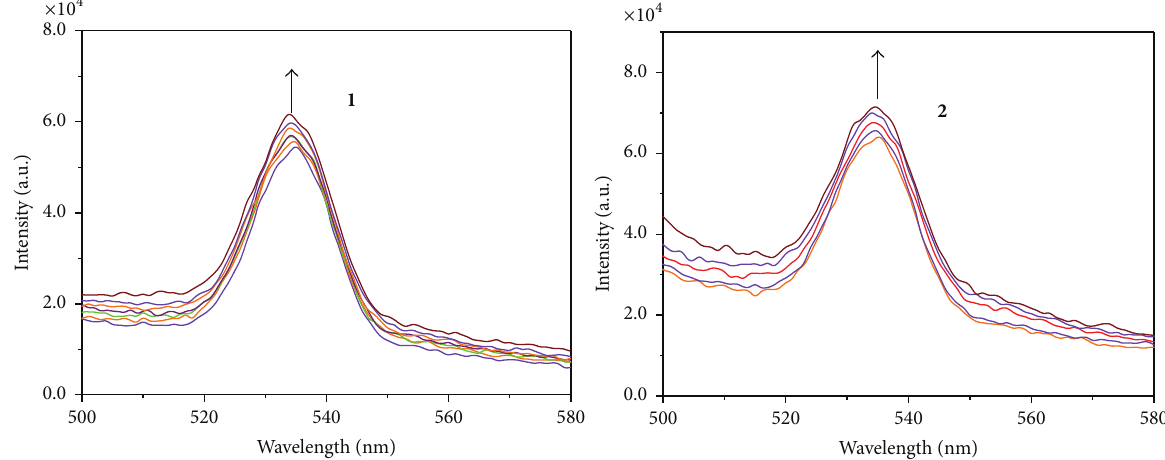
Figure 4: Emission spectra of complexes 1 and 2 in Tris/KCl buffer (100mM KCl, 10mM Tris-HCl, and pH 7.35) with a fixed compound concentration (2.0 × 10 −3 M) and varying the amounts of G4-HTG21 (1.0 × 10 −5 M, 5 𝜇 L per scan), excited at 453